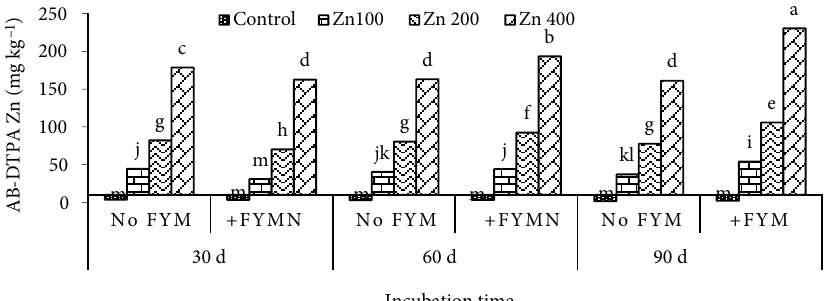
Fig. 3. Effect of incubation time on availability of Zn. FYM – farmyard manure; d – day. Lower case letters indicate the significance of treatments at P <